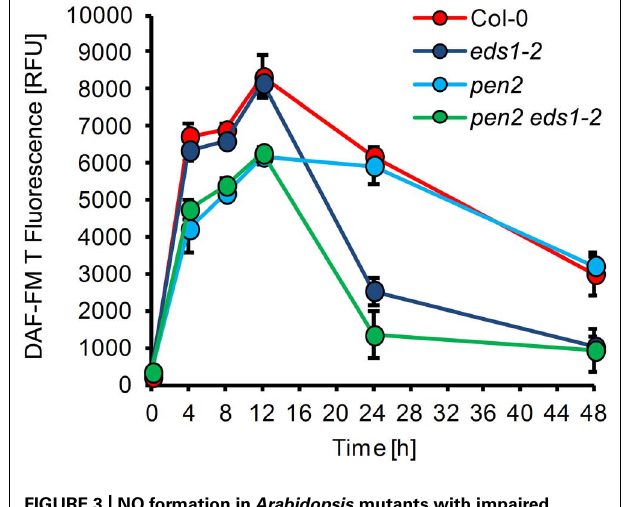
FIGURE 3 | NO formation in Arabidopsis mutants with impaired disease resistance. Leaves of different Arabidopsis thaliana genotypes, Col-0 (red), eds1-2 (purple), pen2 (blue), pen2 eds1-2 (green), were inoculated with the non-adapted powdery mildew Erysiphe pisi and harvested at the indicated times for quantification of NO formation by integration of DAF-FMT fluorescence at infection sites. (For experimental details, see Figure 1 ).Values represent the mean ( ± SD) of 20 infection sites taken from four different leaves of two different